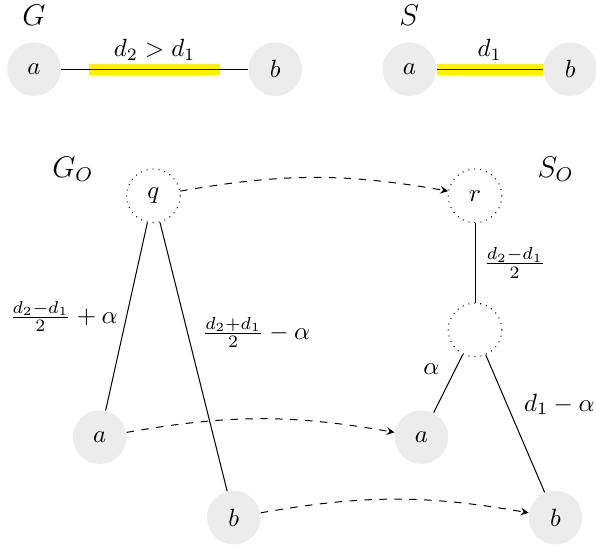
Figure 3. An example of two unrooted trees and their isometric reconciliation, in which the root of G O is mapped to a point above the original root of S . Both input trees consist of only a single edge; the length of the edge is greater in G . Tree S can be rooted in any point, while the corresponding roots of G form an interval of length d 1 in the middle of the edge. Valid roots are highlighted in